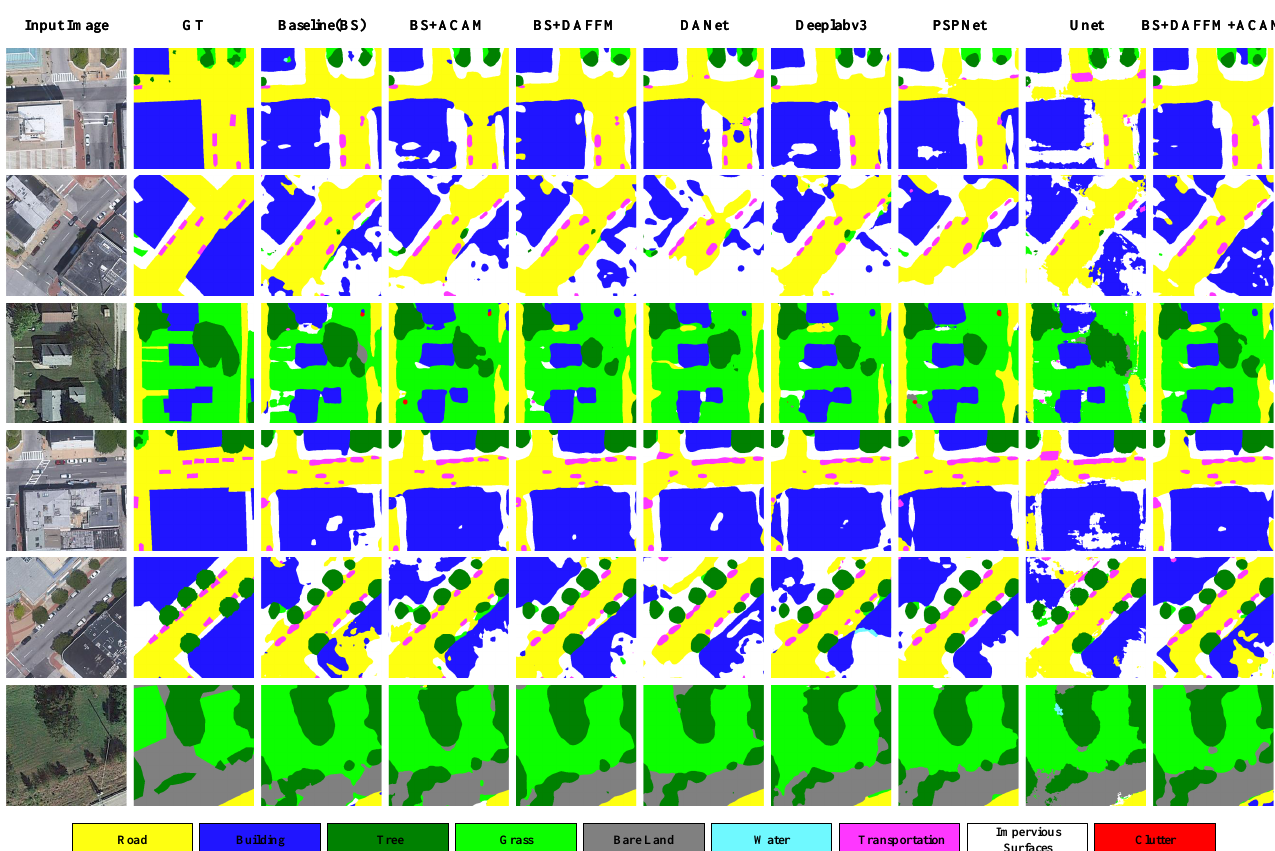
Figure 7. Visualization of the segmentation results for state-of-the-art method based on GaoFen-2 [36]. From left to right, the input image, the ground-truth segmentation results, the results from our methods and the state-of-the-art